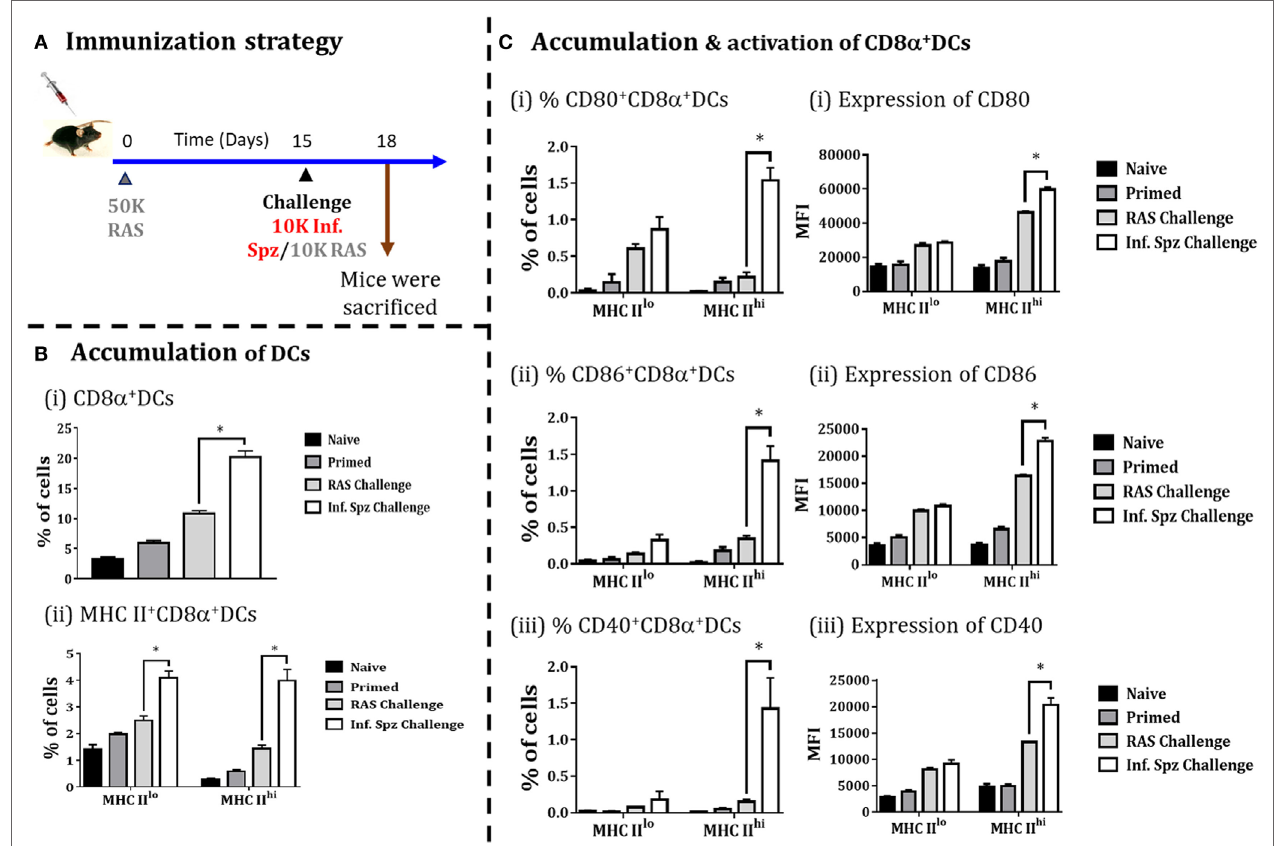
FigUre 6 | Accumulation of CD8 α + dendritic cells (DCs) in the liver in response to challenge with infectious or radiation-attenuated sporozoites (RAS) (10K each) after priming. (a) Immunization strategy. Mice were primed with 50K RAS, on day 15 one group of mice were challenged with 10K infectious sporozoites (Inf. Spz) and another group with 10K RAS. Mice were sacrificed 72 h post-challenge, (B) Accumulation of CD8 α + DCs in the liver of mice post-challenge. (c) Panel showing accumulation and activation status of CD8 α + DCs with the expression of various costimulatory molecules (CD80, CD86, and CD40), (i) CD80, (ii) CD86, and (iii) CD40. Each bar shown in graph is mean of four individual mice per group. Percent cell shown is the percent out of total mononuclear cells or lymphocytes. N = 4 mice per group. Data are the mean ± SEM. The data were analyzed with non-parametric Mann–Whitney U -test. p < 0.05 is considered as a significant. Data shown represent one of two independent